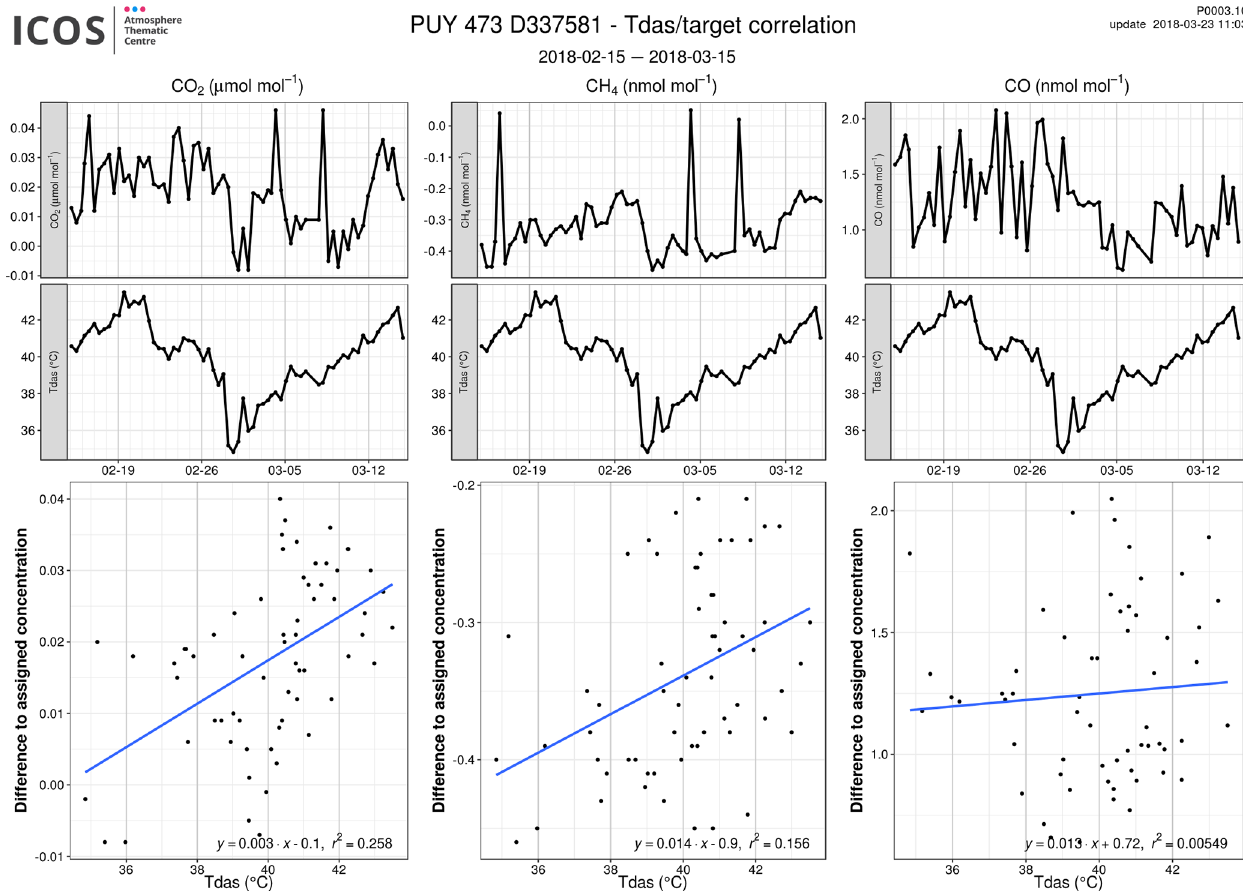
Figure 8. Temperature influence on the measurements at Puy de Dôme station (PUY) for instrument 473 and the target cylinder D337581. On the top: greenhouse gas and instrument temperature (Tdas) measurements against time. On the bottom: greenhouse gas measurements against instrument temperature. In most of the cases, no dependencies are